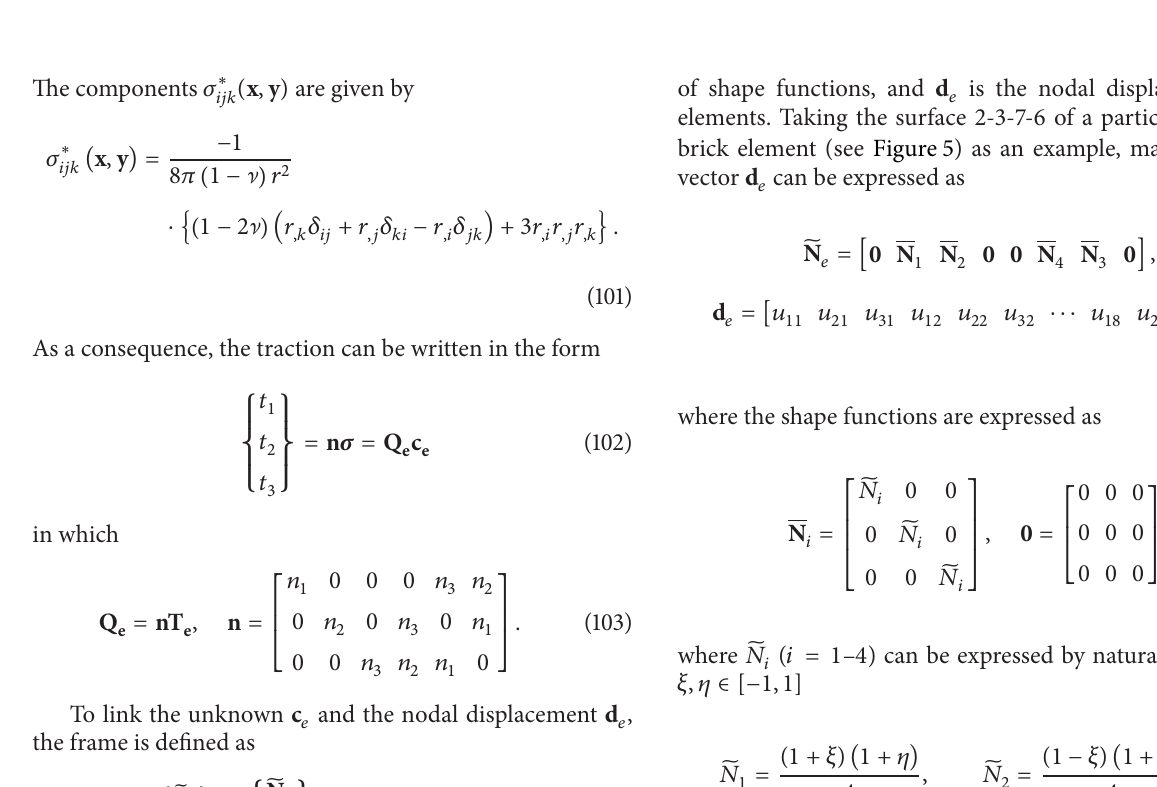
Figure 5: Intraelement field and frame field of a hexahedron HFS-FEM element for 3D elastic problem (the source points and centroid of 20-node element are omitted in the figure for clarity and clear view, which is similar to that of the 8-node element).